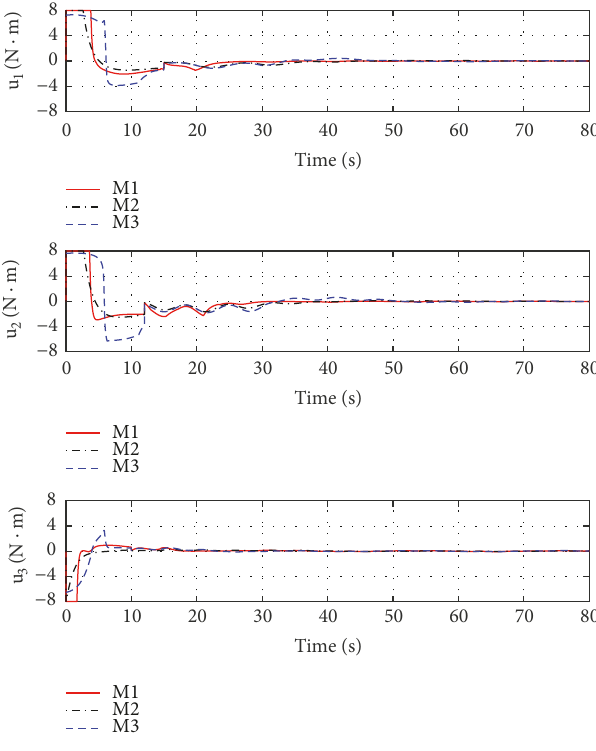
Figure 3: Actual Control torque 𝑢 .